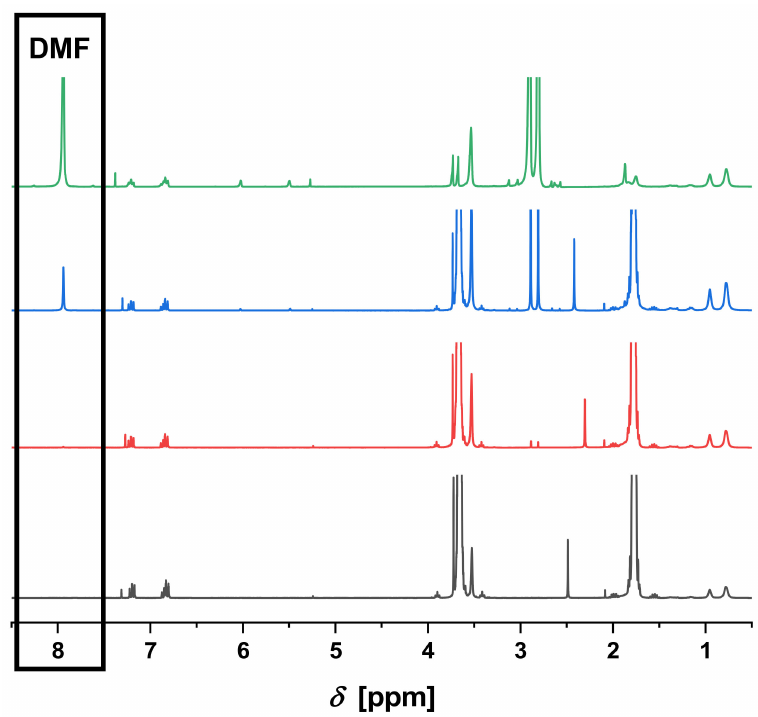
Figure 4. NMR kinetic (CDCl 3 ) of the automated dialysis A4 (modus 2) using the DMF signal at 8.02 ppm (green 0 h, blue 3 h, red 9 h, black 24 h) compared to aromatic anisole signals at 6.75 to 6.90